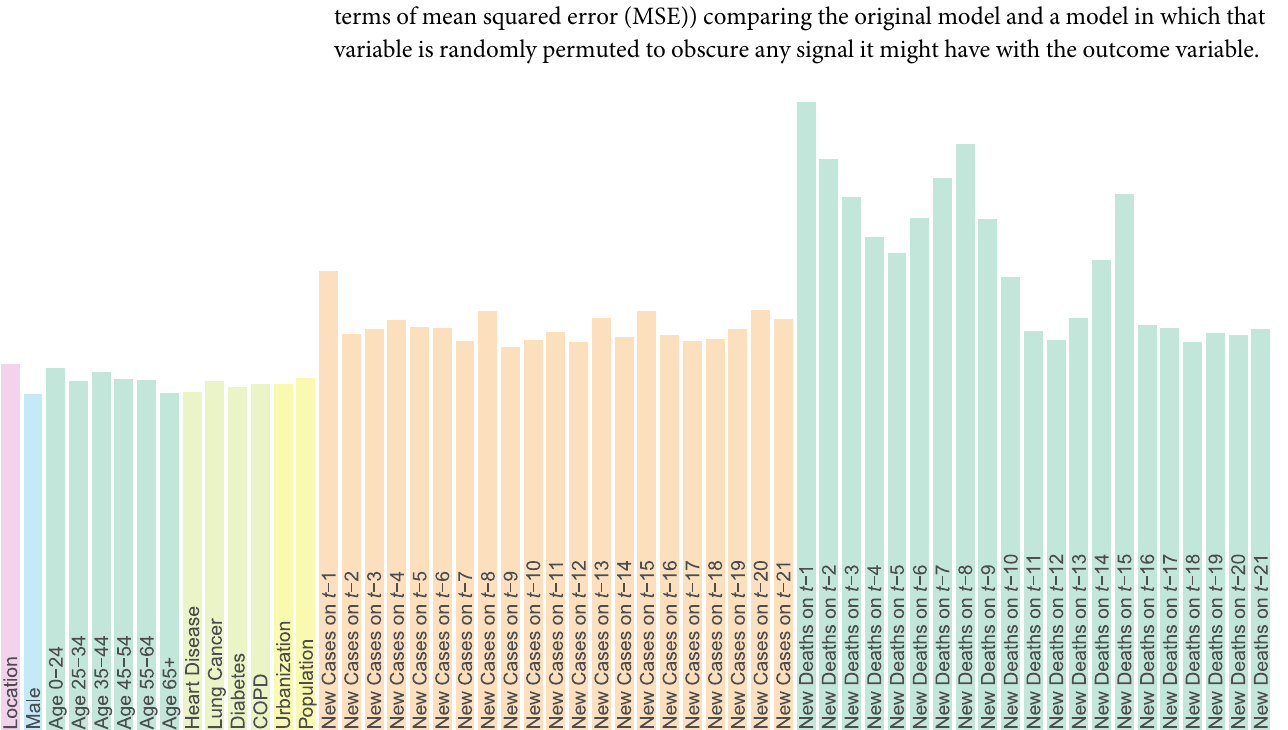
PLOS Computational Biology | https://doi.org/10.1371/journal.pcbi.1008837 March 29,